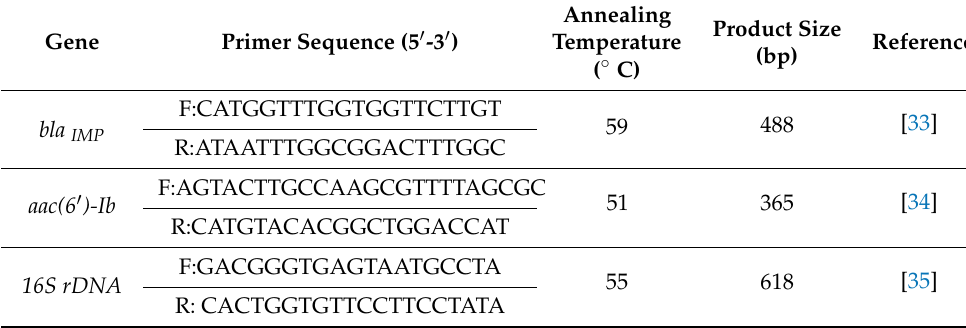
Table 7. The sequences of the primers used in this